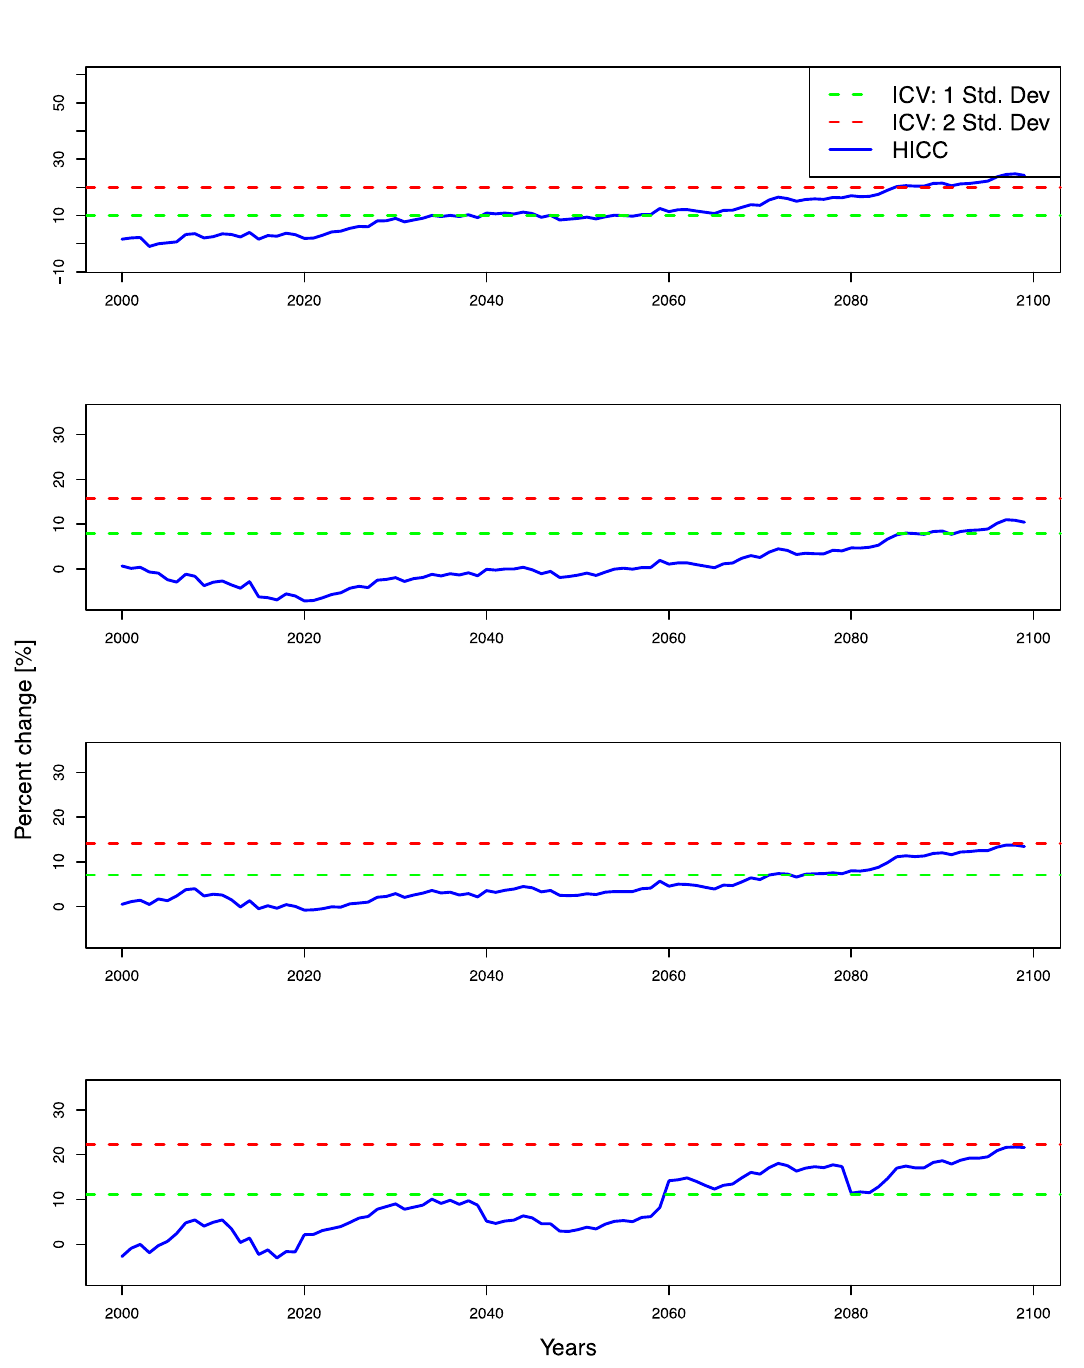
Figure 7. Time of emergence for mean annual streamflow conditions for watersheds (5–8). Table 4. Summary chart showing whether or not time of emergence will occur under different levels of warming in the NEUS watersheds.